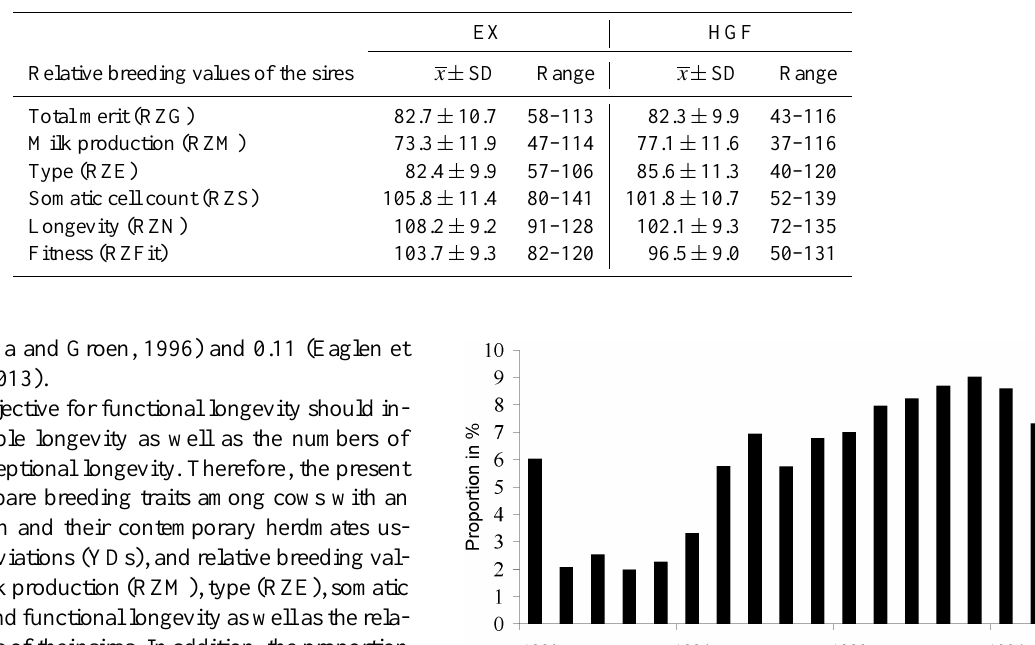
Table 1. Means ( x ), standard deviations (SDs), and range of relative breeding values of the sires of exceptional cows (EX) ( n = 486 sires) and contemporary herdmates (HGF) ( n = 4957 sires).